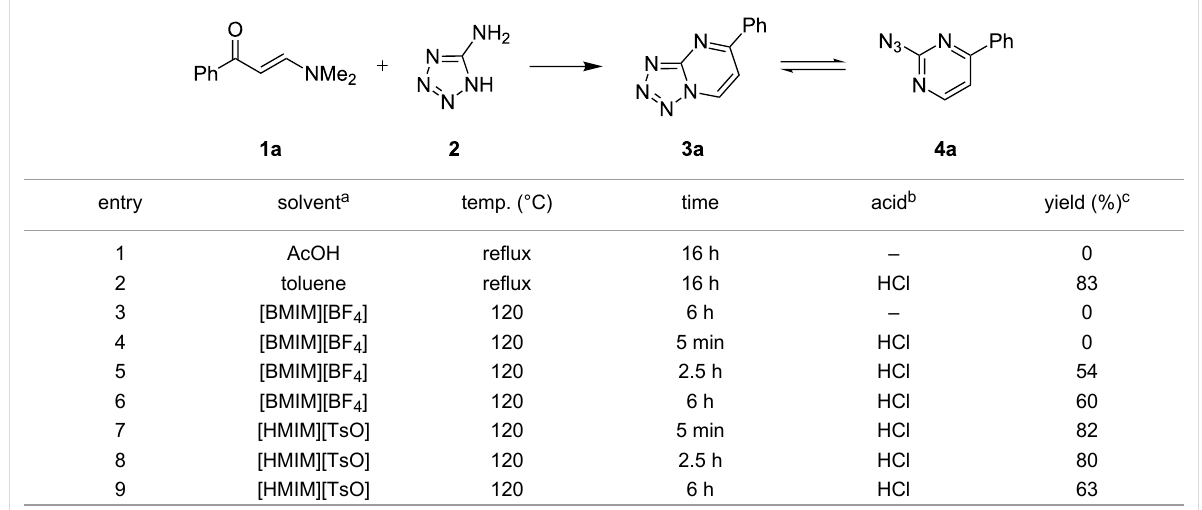
Table 1: Reaction conditions for the synthesis of compounds 3a / 4a .